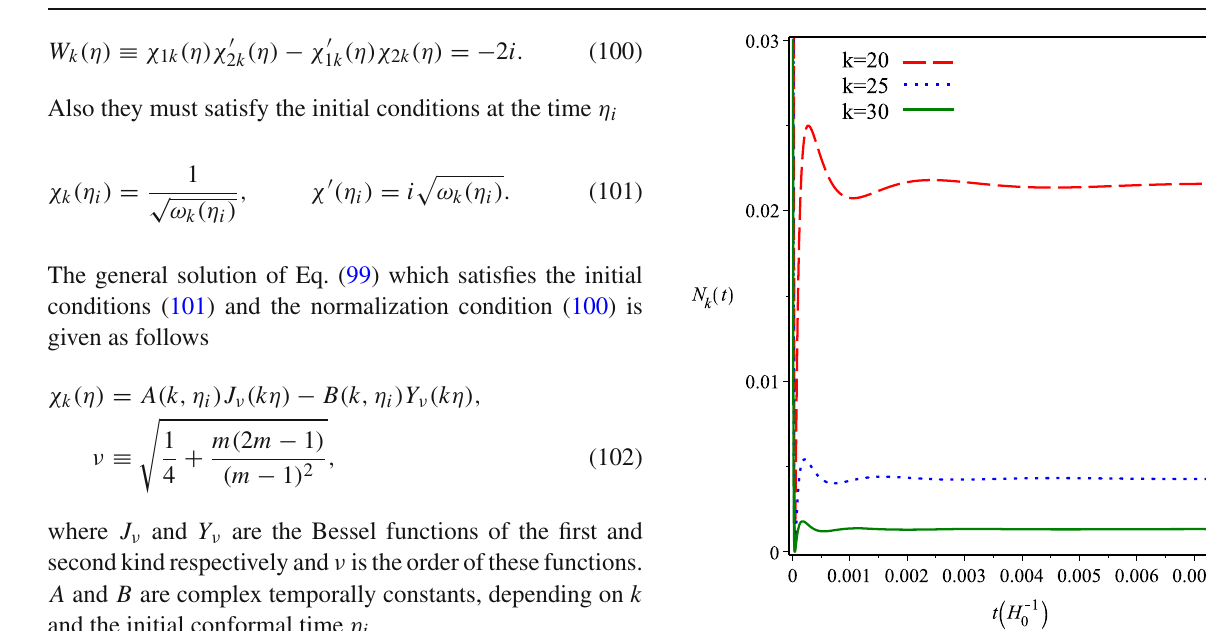
Fig. 2 Evolution of the density of massless created particles N k versus the physical time t (in units of H − 1 ) for three different values of the 0 mode k with the parameter m = 3 / 5 which corresponds to ν = 1